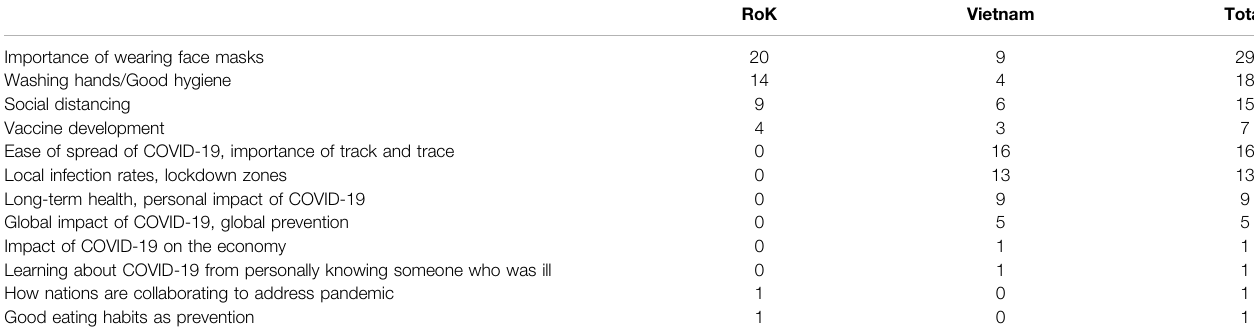
TABLE 4 | Types of Information Judged to be Most Useful During COVID-19.